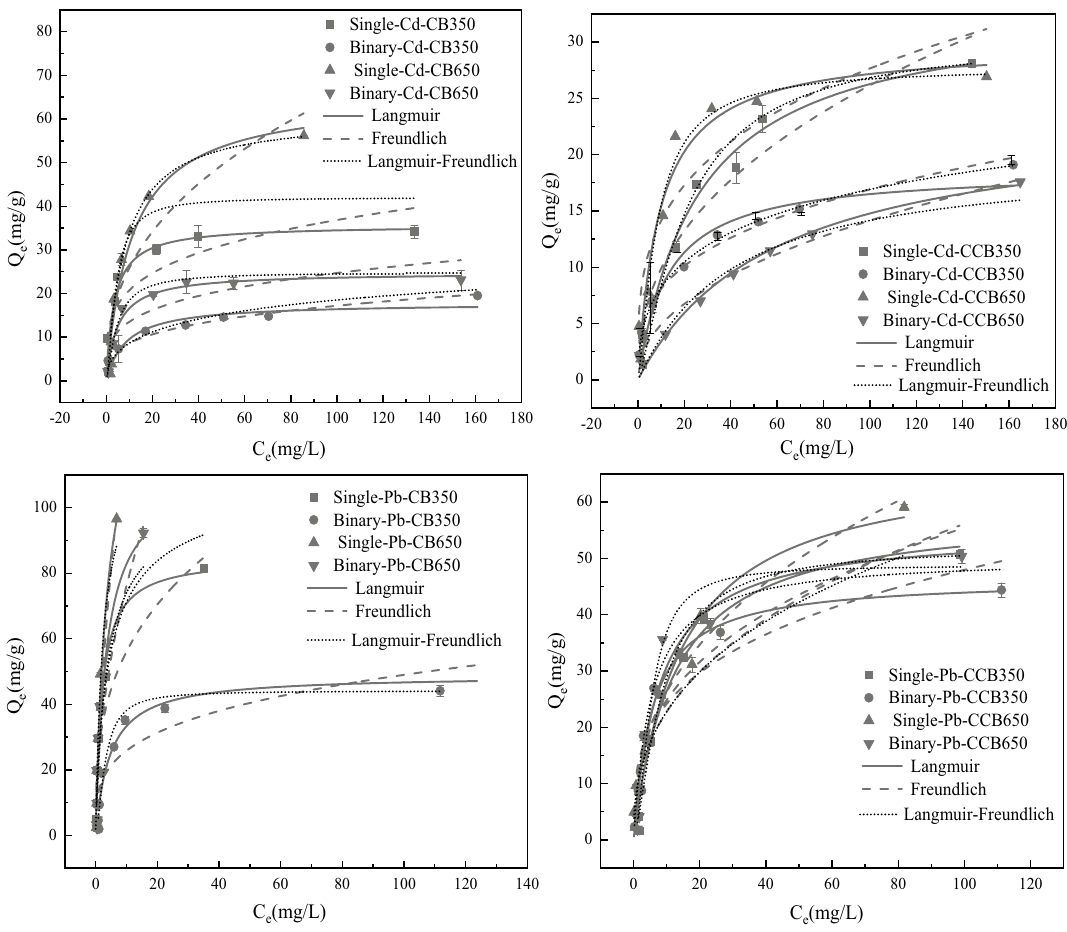
Figure 1. Adsorption isotherms of Pb 2+ and Cd 2+ on the fresh and aged biochars in the single and binary